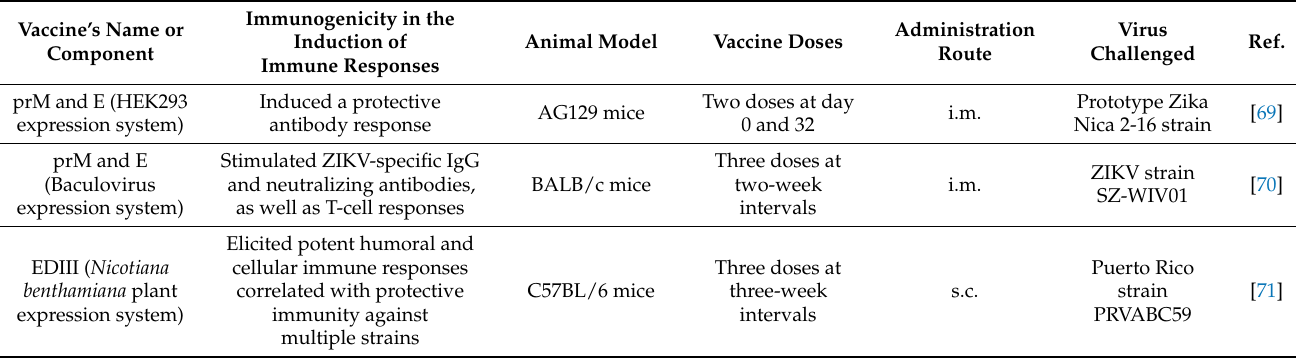
Table 6. VLP- and mRNA-based vaccines against ZIKV